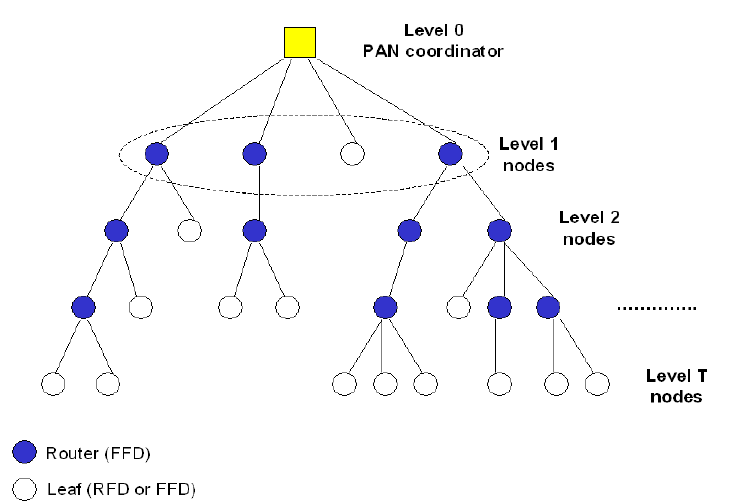
Figure 8. ZigBee-compliant tree network